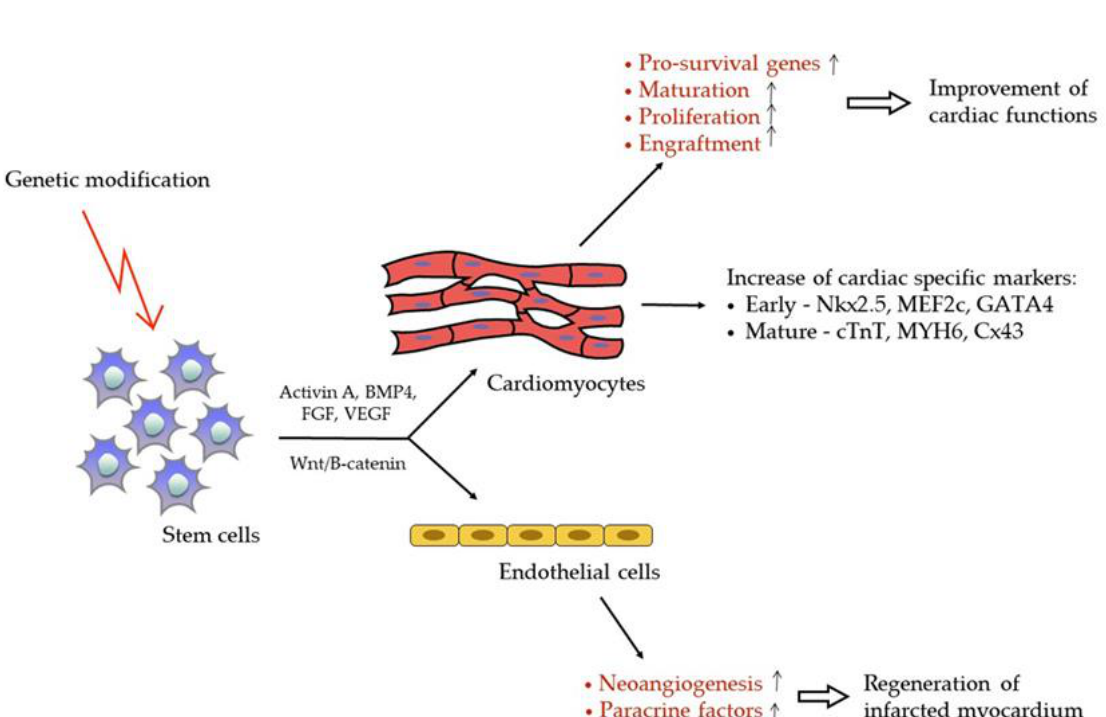
Figure 2. Genetic modification induces stem cells differentiation toward cardiomyocytes and endothelial cells. The process is regulated by Activin A, bone morphogenetic protein 4 (BMP4), basic fibroblast growth factor (FGF2), vascular endothelial growth factor (VEGF), and Wnt/β-catenin factors. Cardiomyocytes derived from stem cells manifest an increased expression of pro-survival genes, progressive maturation, proliferation and high engraftment; those beneficials contribute to a significant improvement of cardiac functions. Endothelial cells promote neoangeogenesis and secrete paracrine factors which help to regenerate infarcted myocardium. Arrows designate an increase in corresponding functions.